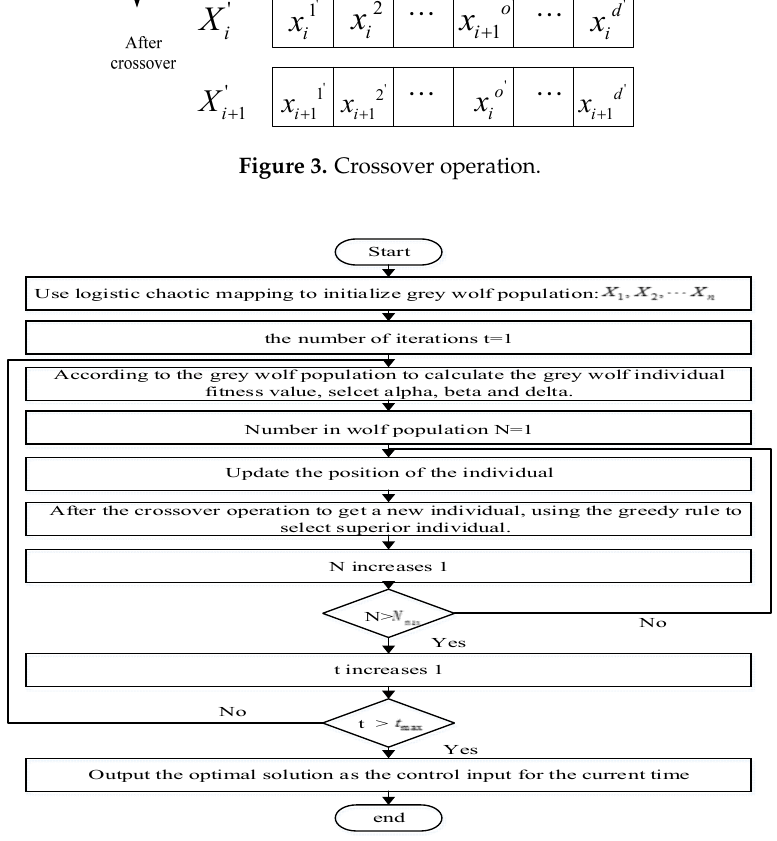
Figure 4. Flow chart of hybrid grey wolf optimization (HGWO).